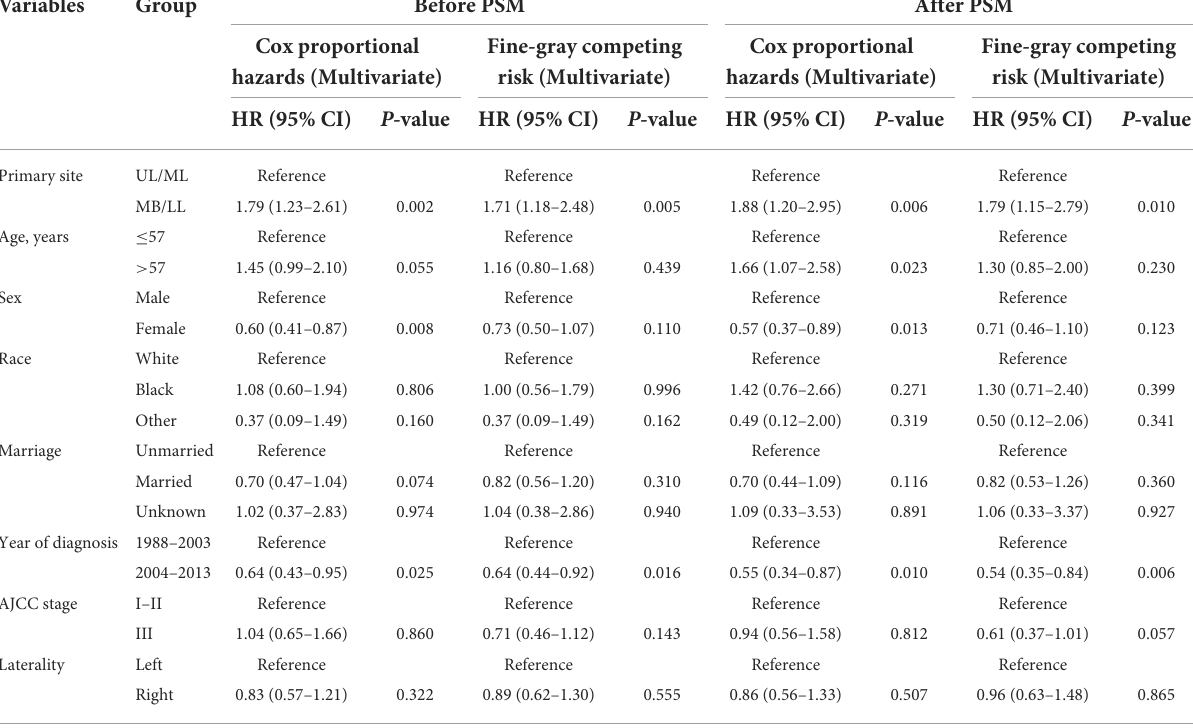
TABLE 5 Multivariate Cox proportional hazards and Fine-Gray competing risk regression models for predictors of CVM before and after PSM.